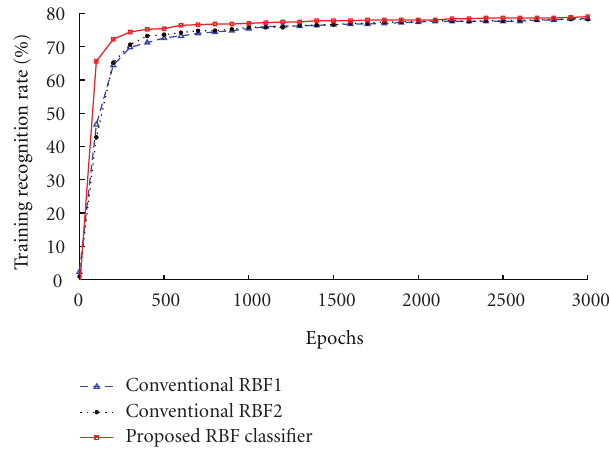
Figure 5: The training recognition rate in RBF networks versus epochs.